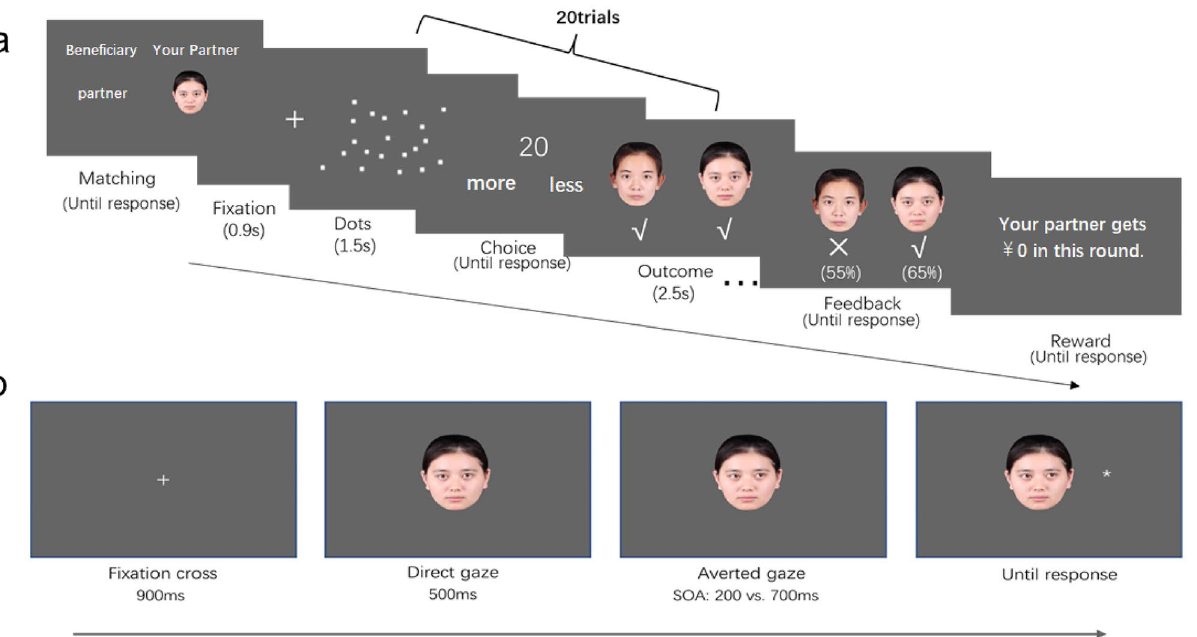
Figure 1. Experiment procedure. Upper panel ( a ): the face-specific guilt-induction task—an example of the guilt condition is depicted. At the beginning of each round, a partner, indicated by a face, and the bonus recipient, indicated by words, were shown. During each trial, images of the participant and the partner’s faces were presented on the outcome and feedback screen. The text in the screenshots of face-specific guilt-induction task was originally Chinese (see Supplemental Material for details). Lower panel ( b ): the gaze-cueing task— sample trials using a congruent condition example. The owners of example facial images consented to